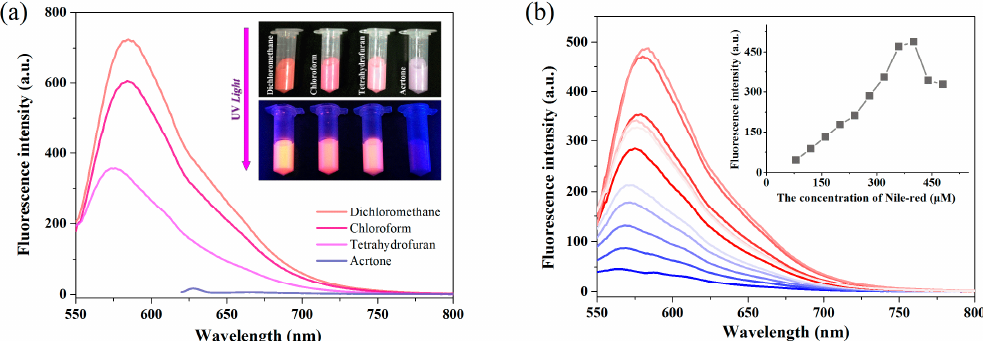
Figure 2. ( a ) The spectrum and photo of microspheres with different solvents; ( b ) The fluorescence intensity at different concentration of NR with the DCM ‐ water as solvent.